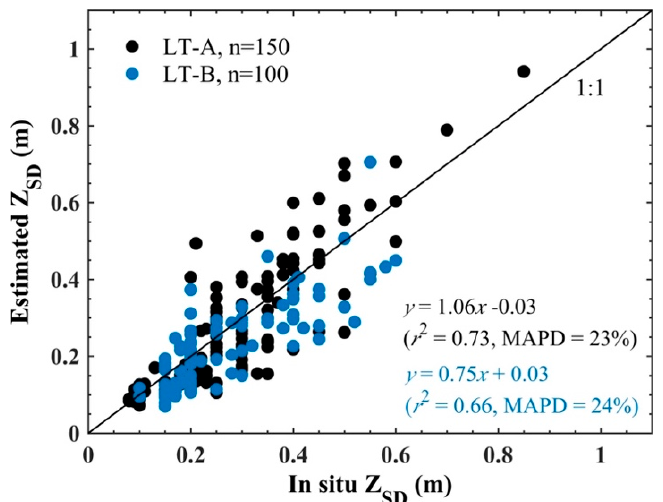
Figure 8. Comparison of estimated Z SD with in-situ measurements in LT-A and LT-B datasets.